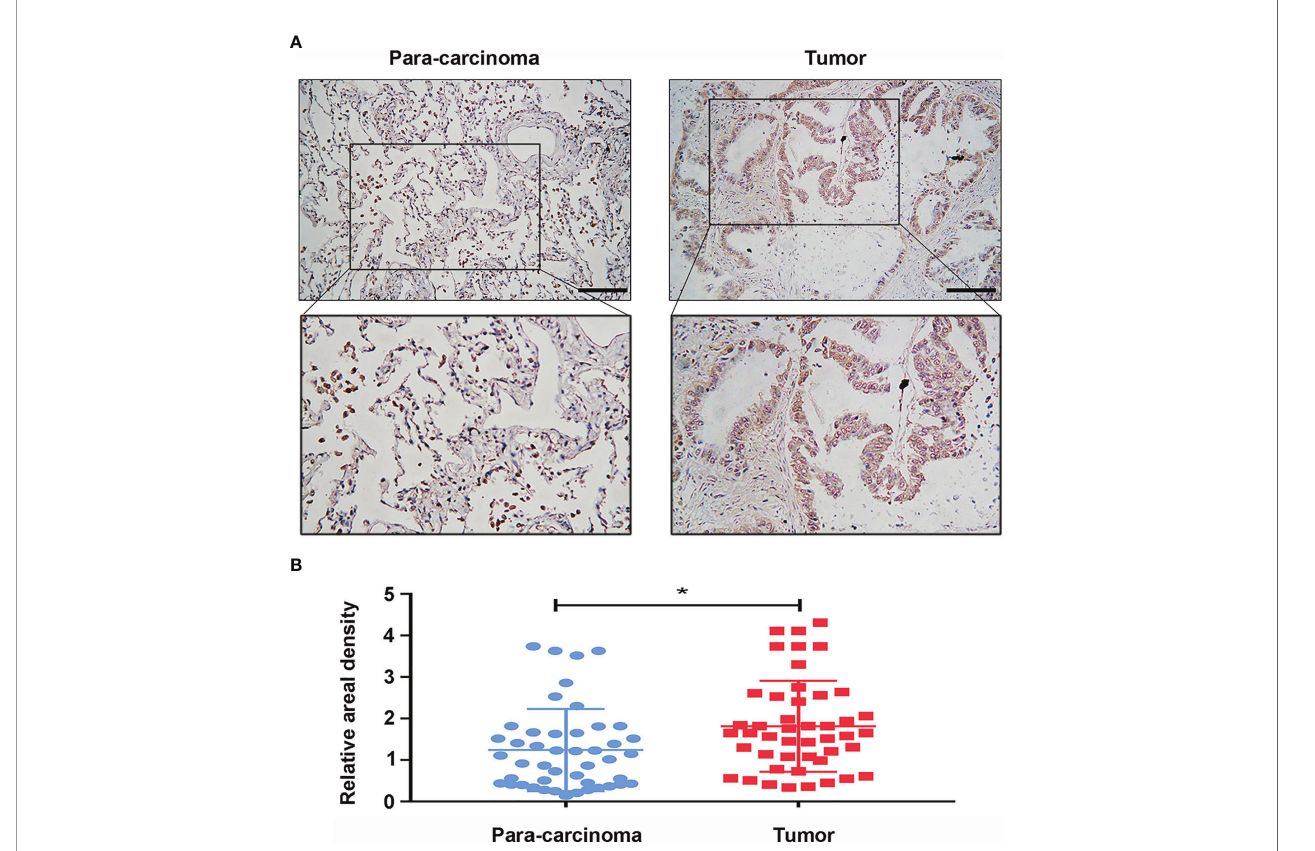
FIGURE 4 | Protein expression of glucose-6-phosphate isomerase (GPI) in clinical specimens of lung adenocarcinoma (LUAD). (A) Immunohistochemical staining of GPI was performed in tumor tissues ( n = 46) and paracarcinoma tissues ( n = 46). Representative images are shown. Score bars , 50 m m. (B) Staining was quanti fi ed, as shown. The dot plot depicts the means and standard deviation of 46 images of tumor tissues and adjacent normal tissues. *p <